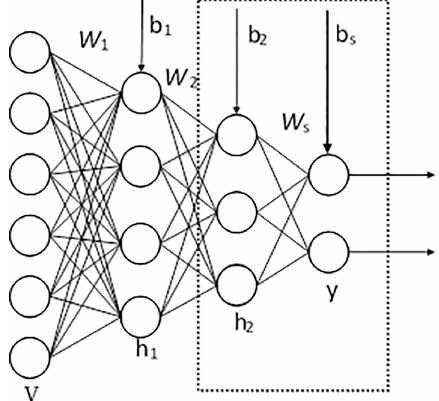
Figure 2. Stacked sparse auto-encoder with two hidden